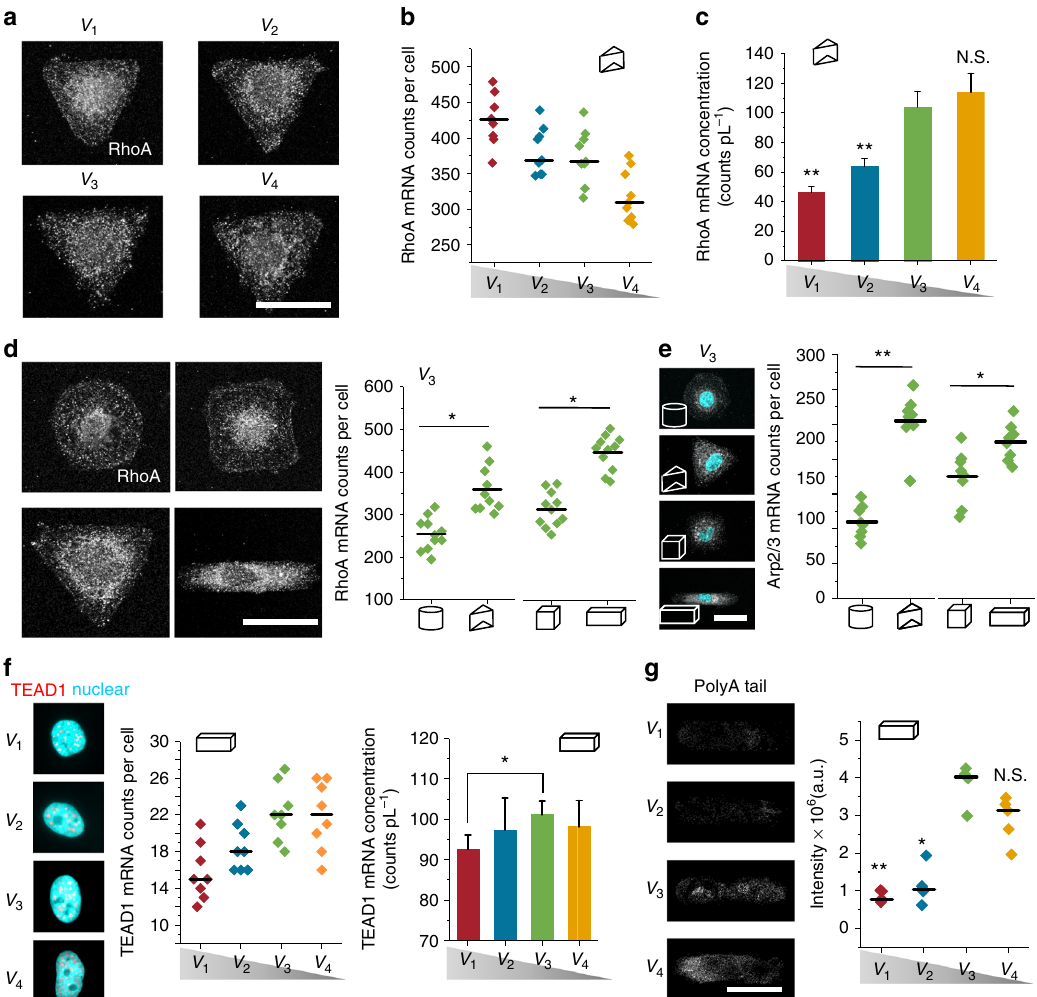
Fig. 5 Size and geometry affect mRNA concentration in cells. a Representative images of RhoA mRNA in cells with different volumes. b , c Counts and concentration (divided by cell volume) of RhoA mRNA in cells with different volumes, narrow lines represent the mean within an individual donor; n = 10 cells per donor and condition. d Representative images and total counts of RhoA mRNA in cells with different geometries but same volume ( V 3 ). e Representative images and total counts of Arp2/3 mRNA in cells with different geometries but same volume ( V 3 ). f Representative images, counts, and concentration (divided by nuclear volume) of TEAD1 in cells with different volumes. g Total mRNA in the middle stack of cells with different volumes; we measured total mRNA by quantifying total fl uorescence intensity from an mRNA FISH probe that detects polyA tail. Data are shown as mean ± s.d. for all panels; n = 30 – 35 cells analyzed for each data point. * P < 0.05, ** P < 0.01 (ANOVA using a Tukey post-test). NS no signi fi cant difference. Scale bar for all images is 20 µ